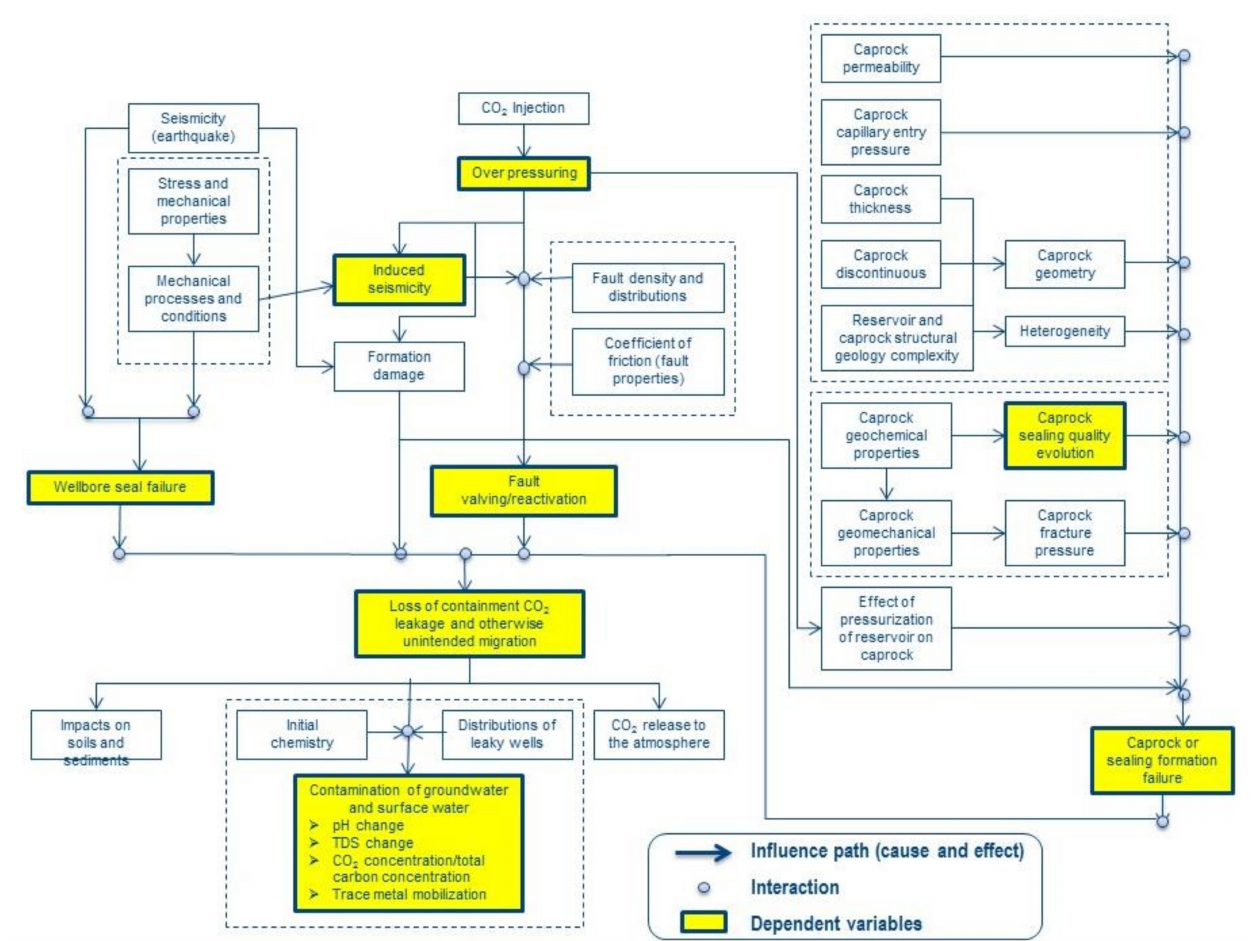
Figure 3. Process influence diagram for geomechanical and CO 2 leakage risks/FEP in SWP Farnsworth project. An arrow shows the influence path and each connection point is represented by a filled